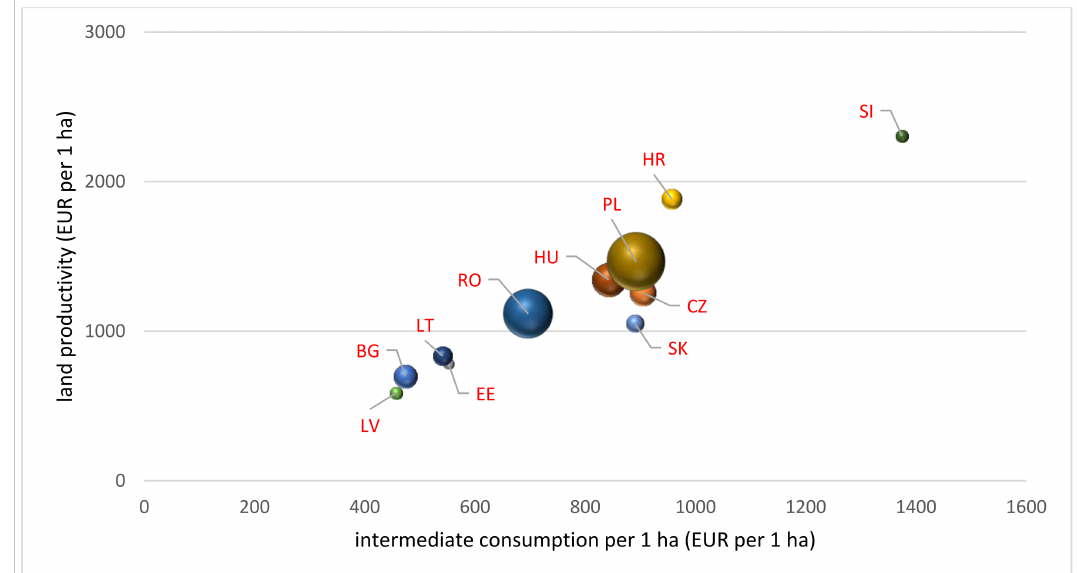
Figure 6. Position of countries forming the EU-13 depending on land productivity, intermediate consumption per 1 ha, and share in the value of agricultural production of the EU from 2010 to 2019. Abbreviations denoting EU-13 countries: Bulgaria, BG; Czechia, CZ; Estonia, EE; Croatia, HR; Cyprus, CY; Latvia, LV; Lithuania, LT; Hungary, HU; Malta, MT; Poland, PL; Romania, RO; Slovenia, SI; Slovakia, SK. Note: The size of the balls refers to the percentage of the EU’s agricultural